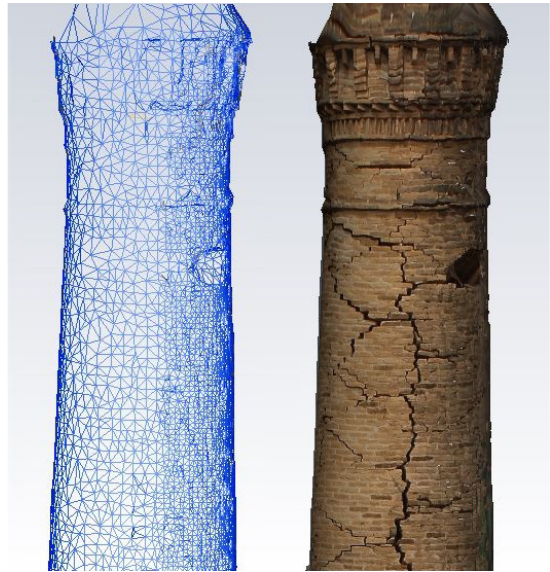
Figure 5: Detail of the TIN model and texturing (source: